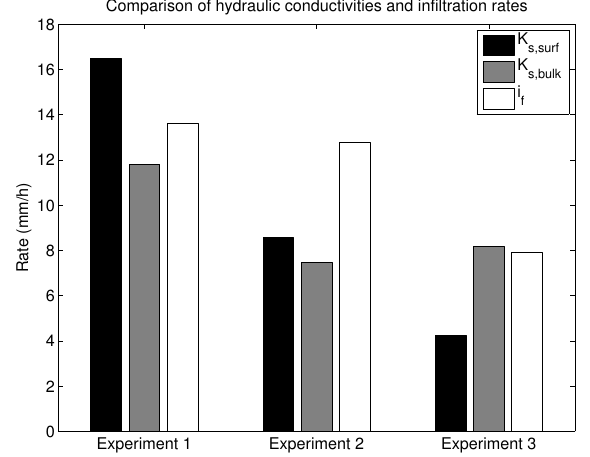
Figure 14. Rates for the optimization using ˆ b and ˆ ψ ae . Figure 12. Comparison of infiltration and conductivity rates for the three